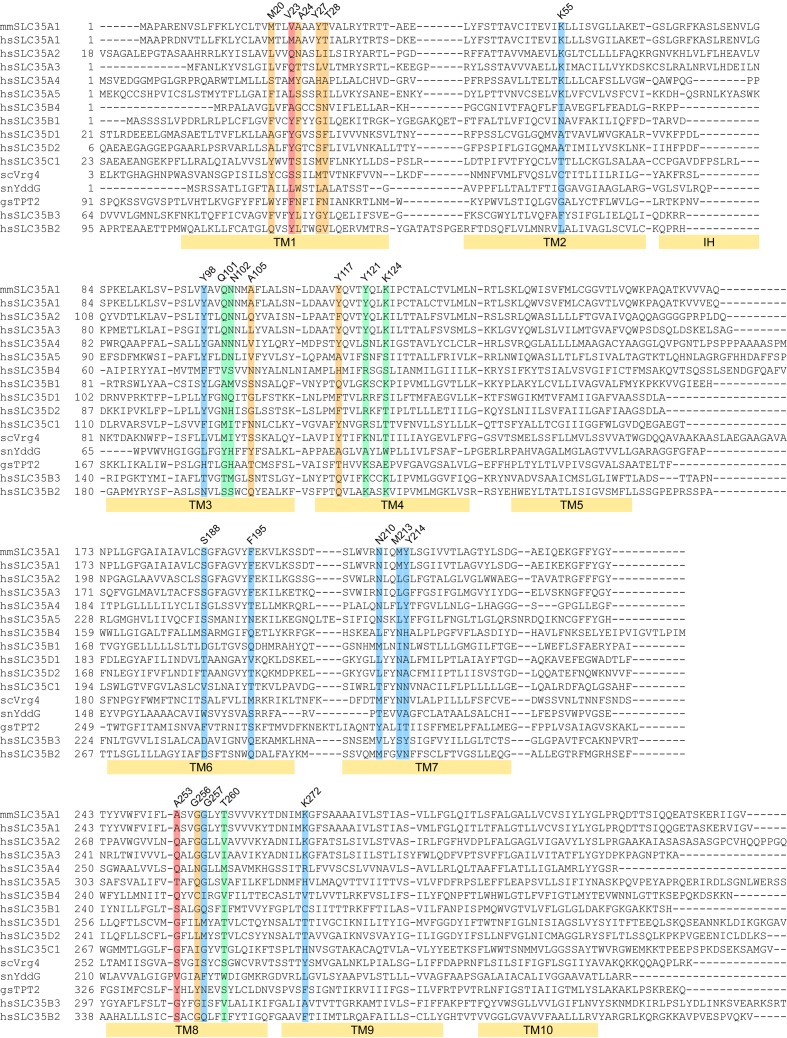
Sequence alignment of mCST with other SLC35 and DMT proteins.The two letter prefix for each sequence name indicates the species as follows: mm: Mus musculus; hs: Homo sapiens; sc: Saccharomyces cerevisiae; sn: Starkeya novella; gs: Galdieria sulphuraria. The colored highlights indicate: CMP-interacting residues (blue), Sia-interacting residues (orange), residues that interact with both CMP and Sia (green), residues that do not interact with CMP or Sia but may interact with sugars in SLC35A2/A3 (red). The labeled yellow bars under the sequences indicate the extent of each TM. The interfacial alpha helix (IH) connecting TMs 2 and 3 is also indicated.